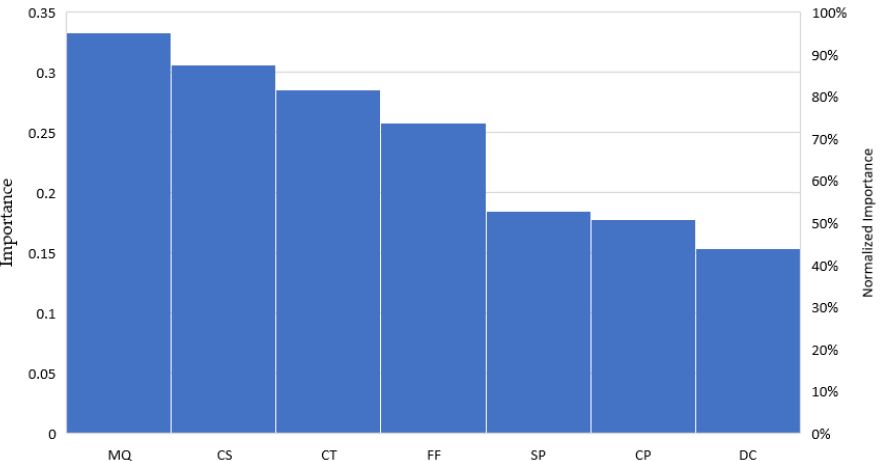
Figure 4. Normalized importance. Source: Developed by the authors based on the data calculated with SPSS Statistics.